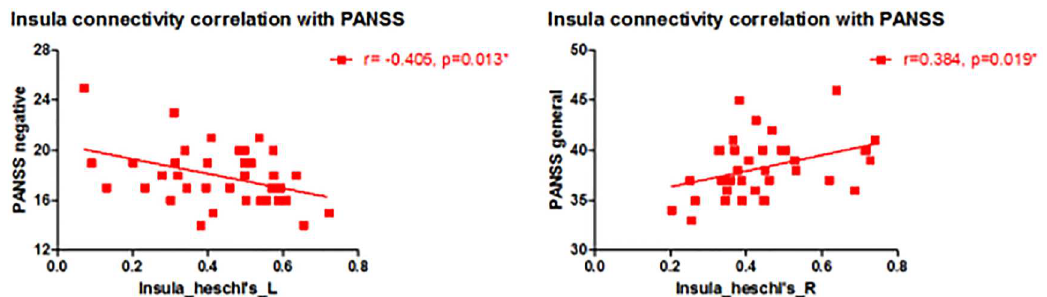
Fig 3. Relationship between insula functional connectivity and clinical